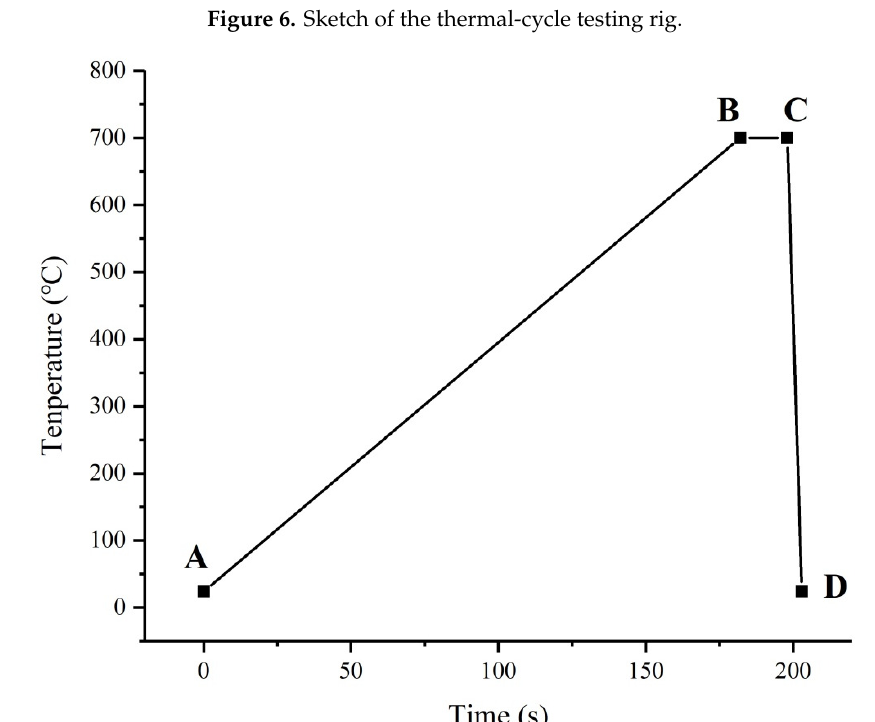
Figure 6. Sketch of the thermal-cycle testing rig.